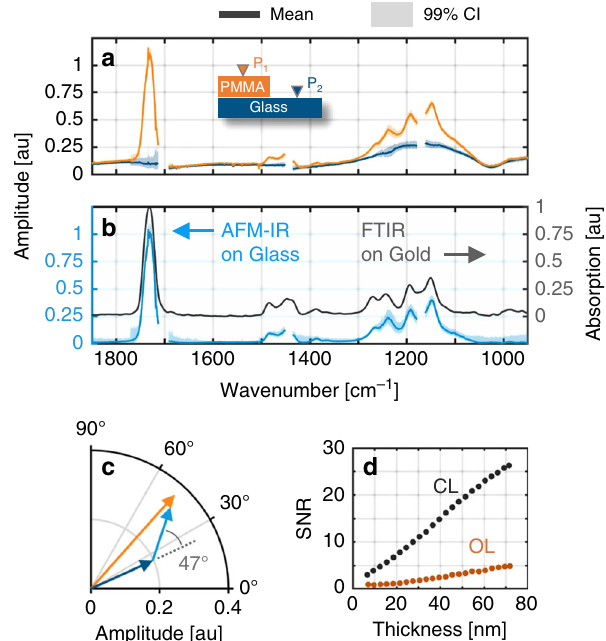
Fig. 4 Nanoscale infrared absorption measurements on glass. a Infrared point spectra collected in closed-loop on 100 nm PMMA fi lm (orange) and on glass substrate (blue). Data were omitted at QCL laser transitions due to artifacts and increased noise resulting from insuf fi cient spot focus and low laser power. b Difference spectrum of PMMA and glass spectra from ( a ) compared with FT-IR re fl ection-absorption spectra of 100 nm PMMA fi lm on gold. c Complex amplitude of point and difference spectra at 1244 cm − 1 . The PMMA signal is 47 degrees out-of-phase from the baseline which was attributed to thermal diffusion. d Signal to noise ratio (SNR) versus fi lm thickness of difference spectrum signal at 1732 cm − 1 for closed-loop and open-loop